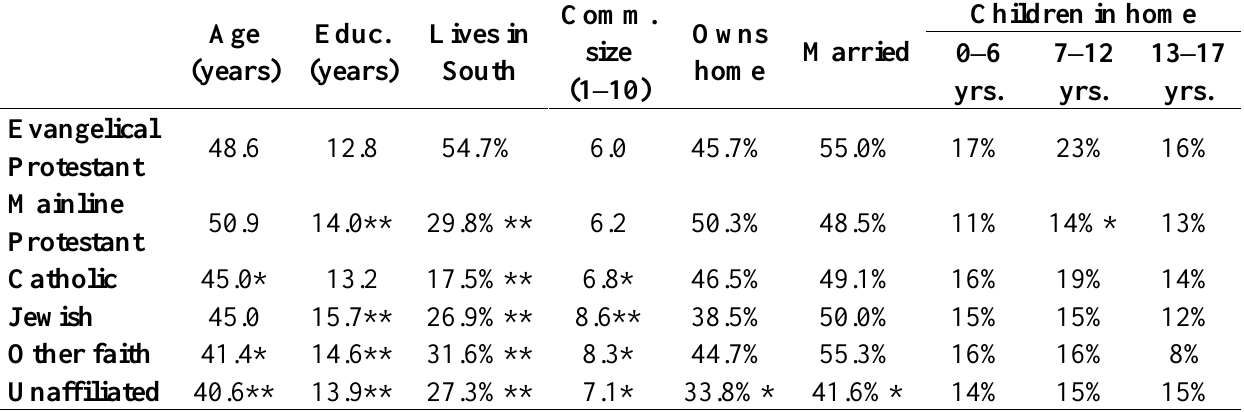
Table 2. Comparison of Evangelical Protestants to Other Groups on Key Socio-Demographic